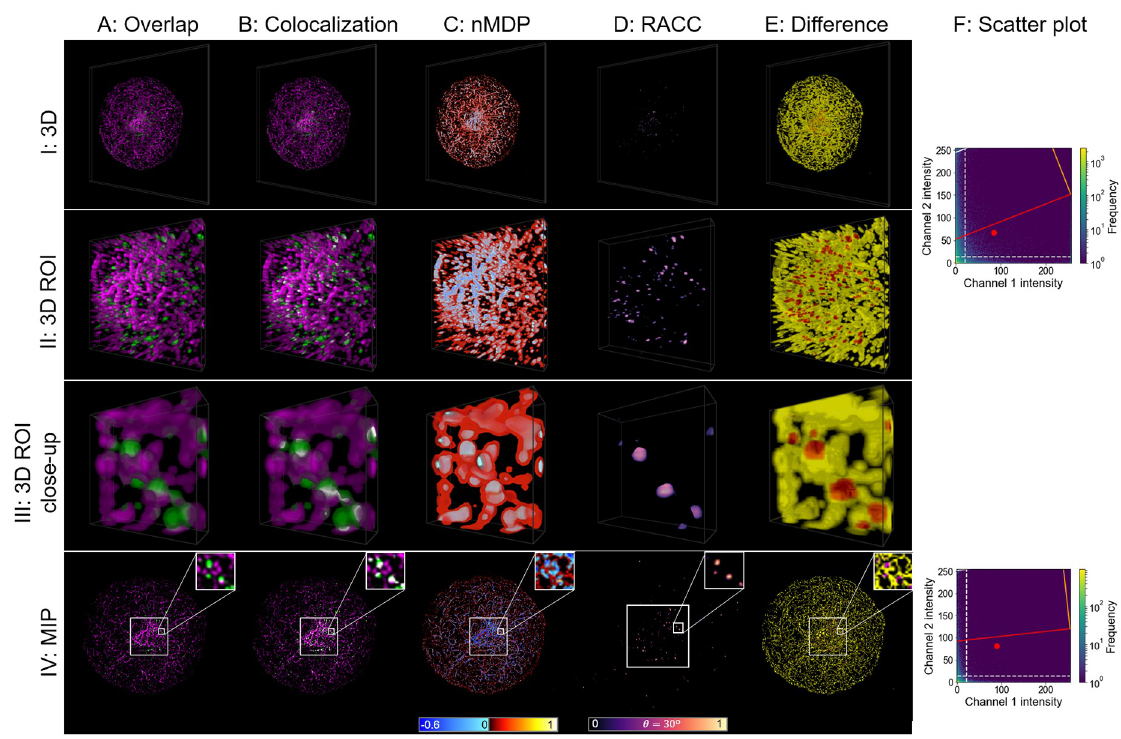
Fig 8. Autophagasome (green) and tubulin (magenta) visualisation. The structure of the figure is similar to that of Fig 5, but in this case biological samples and not synthetic data are considered.